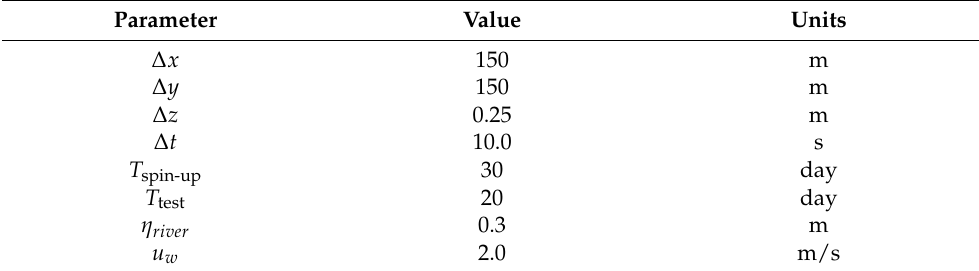
Table 5. Parameters for modeling the Trinity River Delta. Parameter values for φ , θ r , α , and ˆ n are as listed in Table 1. Parameter values for n , K s and q e ( surface water ) are as listed in Table 3. Parameter Value Units ∆ x